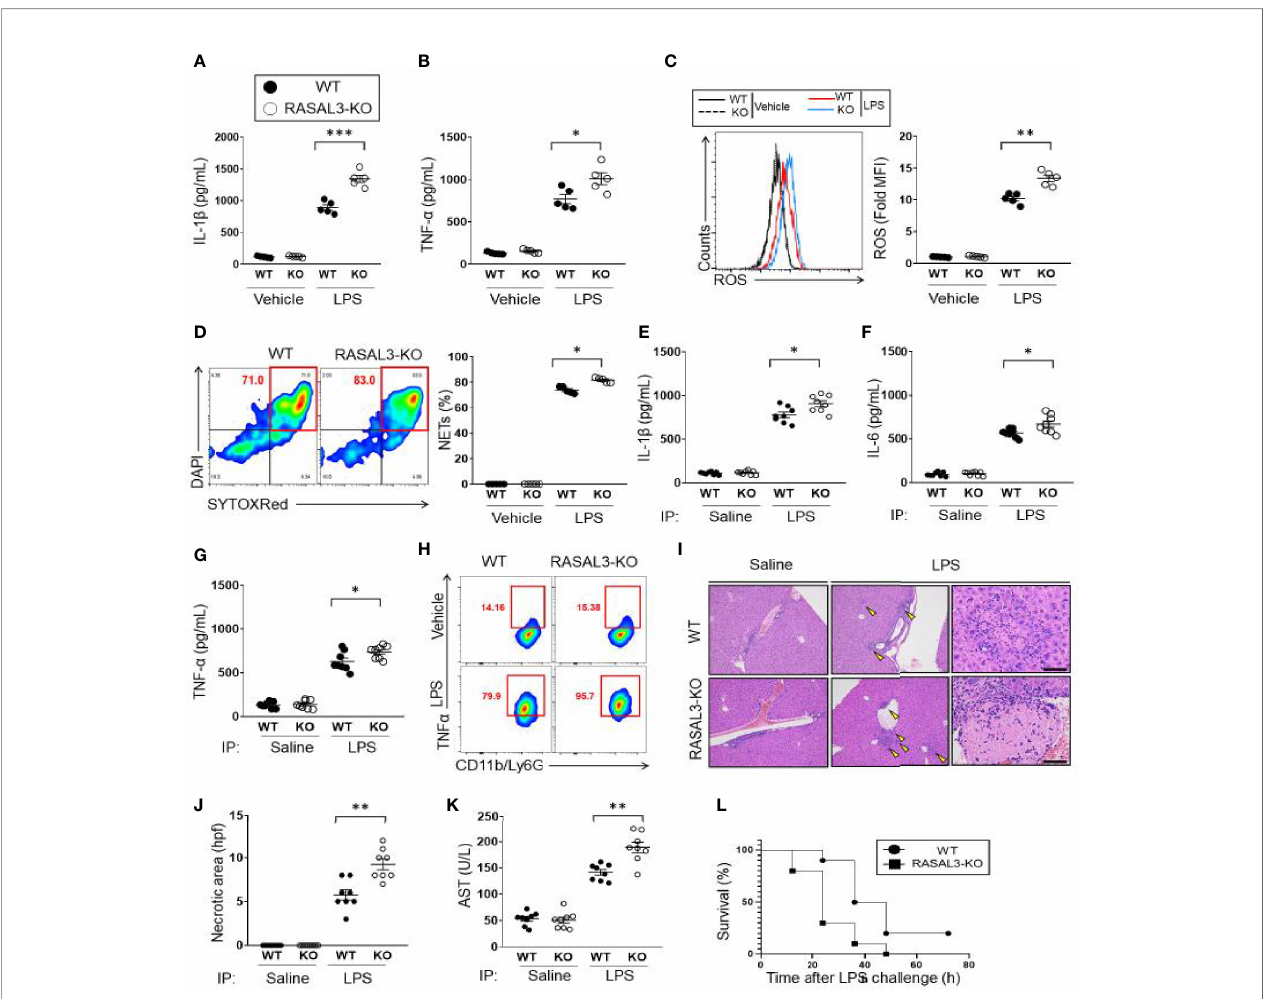
FIGURE 3 | RASAL3-de fi ciency exaggerates in fl ammatory response in neutrophils. (A, B) In fl ammatory cytokine production in neutrophils. Bone marrow isolated neutrophils were incubated with vehicle control or LPS at 37°C for 24 h. The production of IL-1 b (A) and TNF- a (B) were detected by ELISA. (C, D) ROS production in neutrophils. BM isolated neutrophils were incubated with vehicle control or LPS at 37°C for 30 min. Flow cytometry was used to determine CellROX-Green assay fl uorescence. A representative fl ow cytometric plot and calculated mean fl uorescence intensities (MFI) are shown. (D) NET production by BM isolated neutrophils. After treatment with vehicle or LPS, SYTOXRed+DAPI+ cells were quanti fi ed as fraction of neutrophils undergoing NETosis. E-H). In vivo cytokine production by WT and RASAL3-KO mice. Mice received i.p. injection of LPS or saline (vehicle control). At 12 h, serum was collected, and IL-1 b (E) , IL-6 (F) , TNF- a (G) were measured by ELISA. (H) Intracellular cytokine (TNF- a ) measurement of neutrophils in LPS-challenged WT and RASAL3-KO mice. 6 h after LPS challenge (or control injection), blood was harvested from WT and RASAL3-KO mice, and the proportion of neutrophils (C11b/Ly6G) staining positive intracellular TNF- a were determined by fl ow